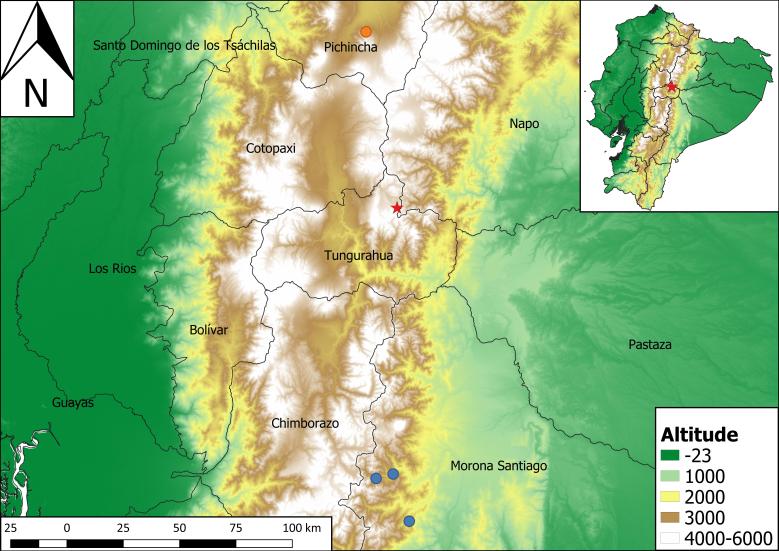
Records for Nasuella
olivacea in Ecuador. Red star: this record (3,862 m a.s.l.); Orange circle: Previous highest altitudinal report with a supporting document for Ecuador (3,357 m a.s.l.) (Ramírez 2011); Blue circles: Other records reported for Ecuador (2,300; 2,500 and 2,800 m a.s.l.) (Brito and Ojala-Barbour 2016)